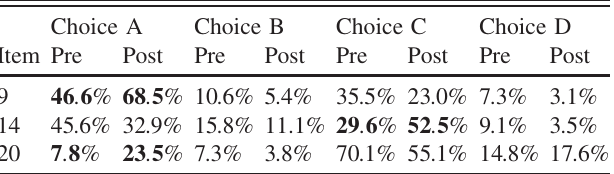
TABLE IV. Pre- and postinstruction responses of LEPS stu- dents on specific PSQ items. Numbers are percentages of all 425 LEPS students with matched preinstruction and postinstruction responses. Correct responses are in